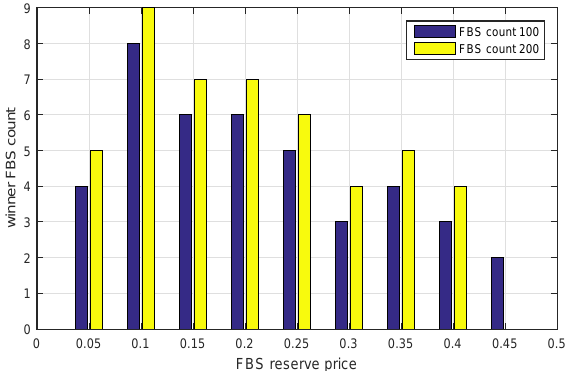
Figure 13. The winner FBS Count distribution under different FBS counts.